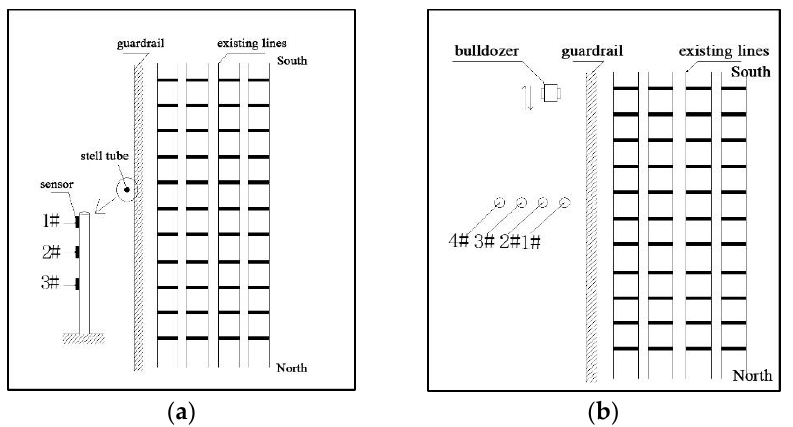
Figure 3. Monitoring of measuring points. ( a ) is schematic of sensor placement; ( b ) is schematic diagram of steel pipe laying.